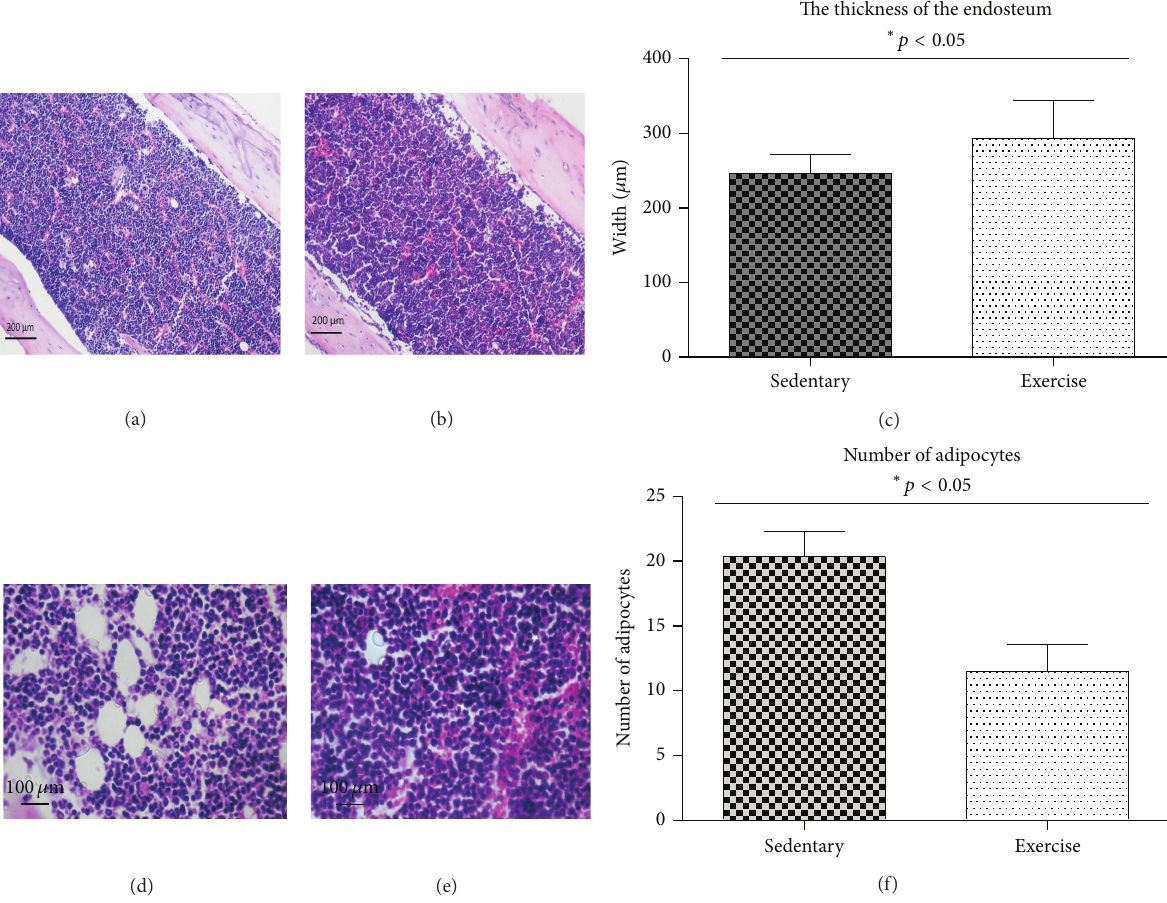
Figure 7: The morphology of the bone marrow cavity and endosteum in sedentary (a) and exercised animals (b). Representative images, taken in the central area of the marrow cavity, of bones stained with hematoxylin and eosin from sedentary (d) or exercise-trained animals (e). The thickness of murine endosteum in exercise-trained animals and sedentary group (c) and the total number of adipocytes in the bone marrow cavity in sedentary and endurance exercising animals (f). Number of adipocytes normalized on photo areas. Statistical significance ( 𝑝 < 0.05